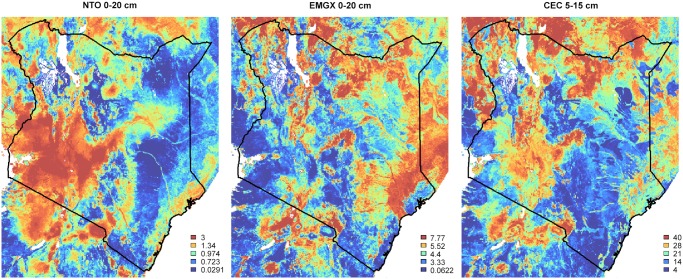
Spatial patterns of predicted total nitrogen (in permilles), exchangeable Mg (cmol+/kg) and CEC (cmol+/kg) for topsoil for Kenya.Legends were set using equally spaced quantiles. White pixels indicate excluded areas (water bodies and deserts). Each soil property is modelled independently and can thus show quite different spatial patterns.